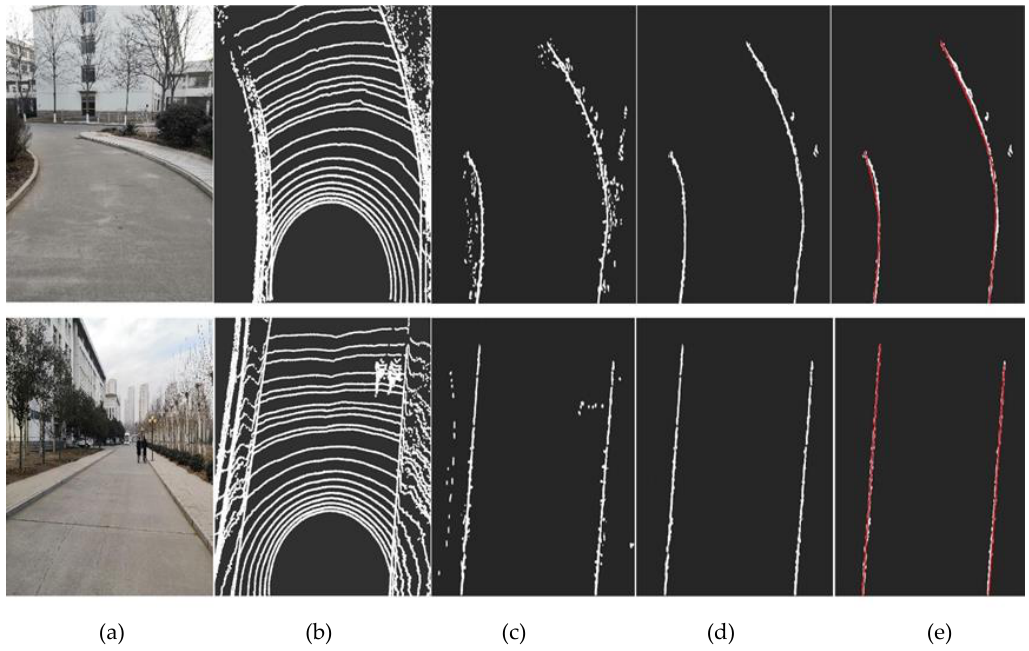
Figure 11. The effect of road boundary extraction, ( a ) represents actual roads collected for the